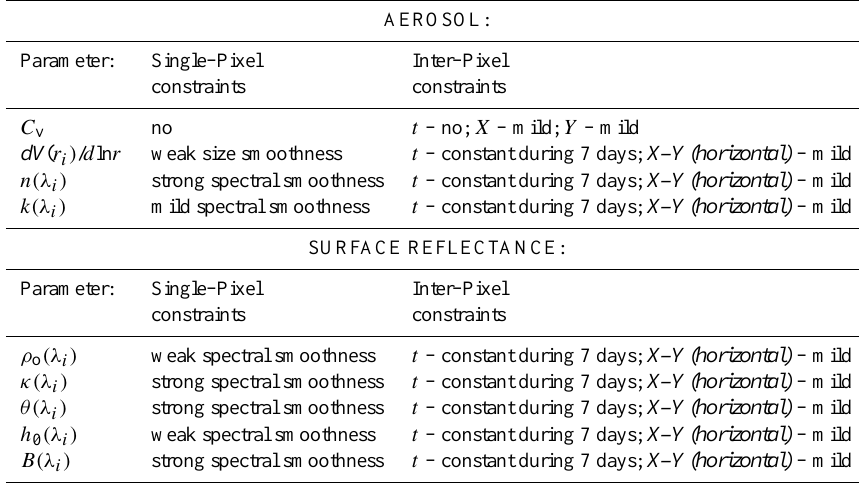
Table 5. Summary of the a priori assumptions applied for constraining of each element of the vector of unknowns.